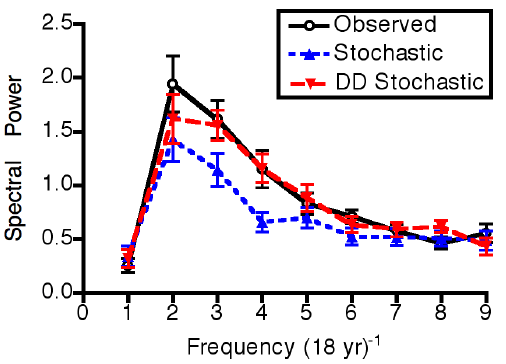
Figure 5. Spectral analysis of observed data (Fig. 1) and of model results both with (Fig. 4) and without (Fig. 7) density- linked stochasticity. The graph depicts the relative contribution of trigonometric functions of different recurrence frequencies spanning the 17-year observation period. Error bars represent one standard error.